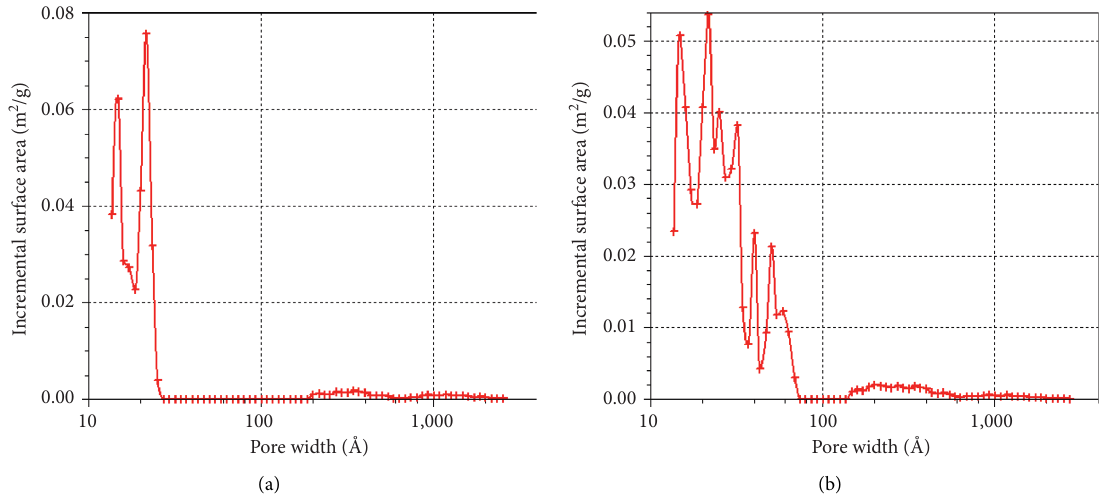
Figure 6: Relationship between the specific surface area increments of the coal and the pore diameters of the No. 8 coal seam (˚A is 10 − 1 nm): (a) hard coal; (b) soft coal.